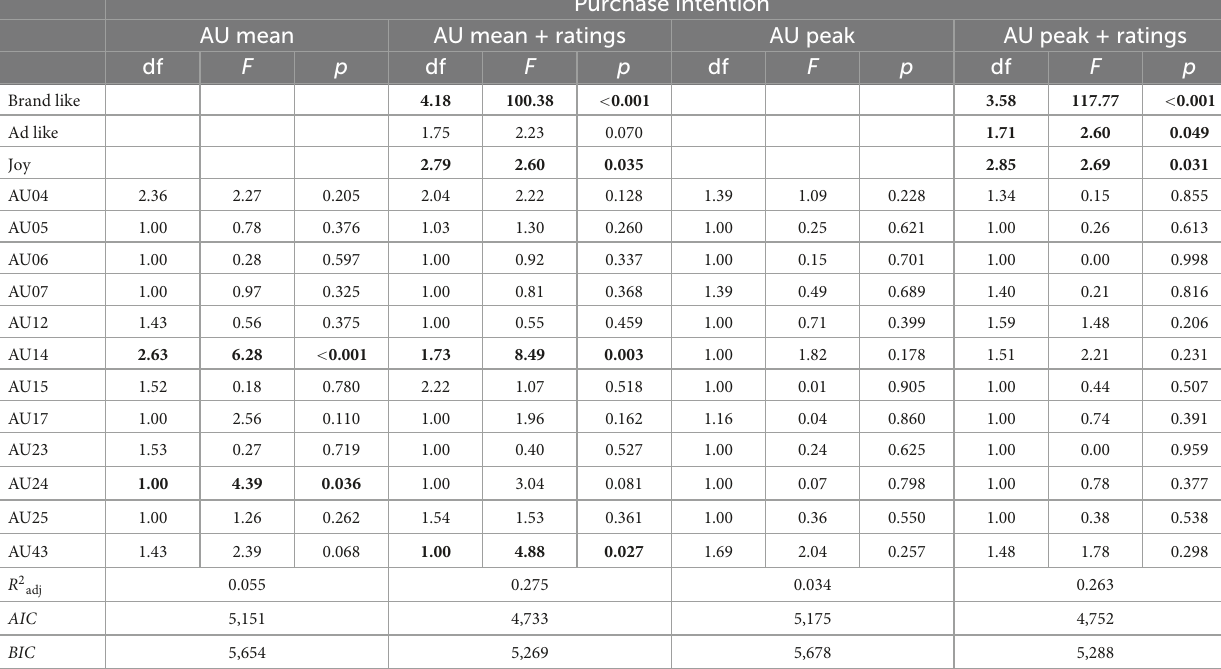
TABLE 6 Prediction of brand purchase intention change rating based on mean and peak Action Unit (AU) activity with and without self-report ratings. Purchase